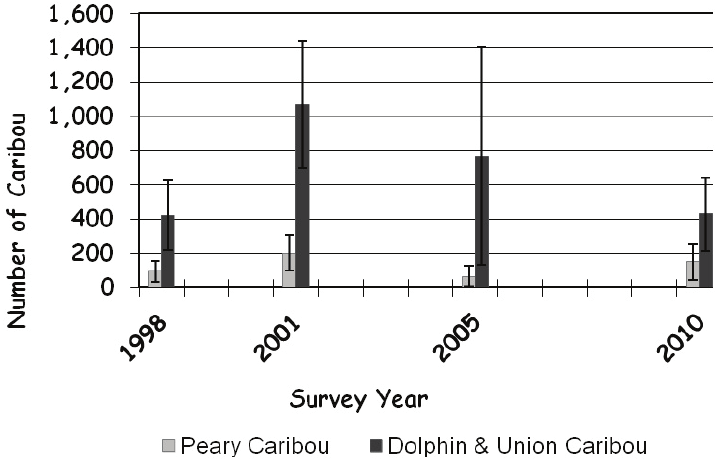
Fig. 3. Population counts of adult Minto Inlet Peary caribou and Dol- phin-Union caribou on northwest Victoria Island, NWT with 95% confidence intervals around the population estimates.